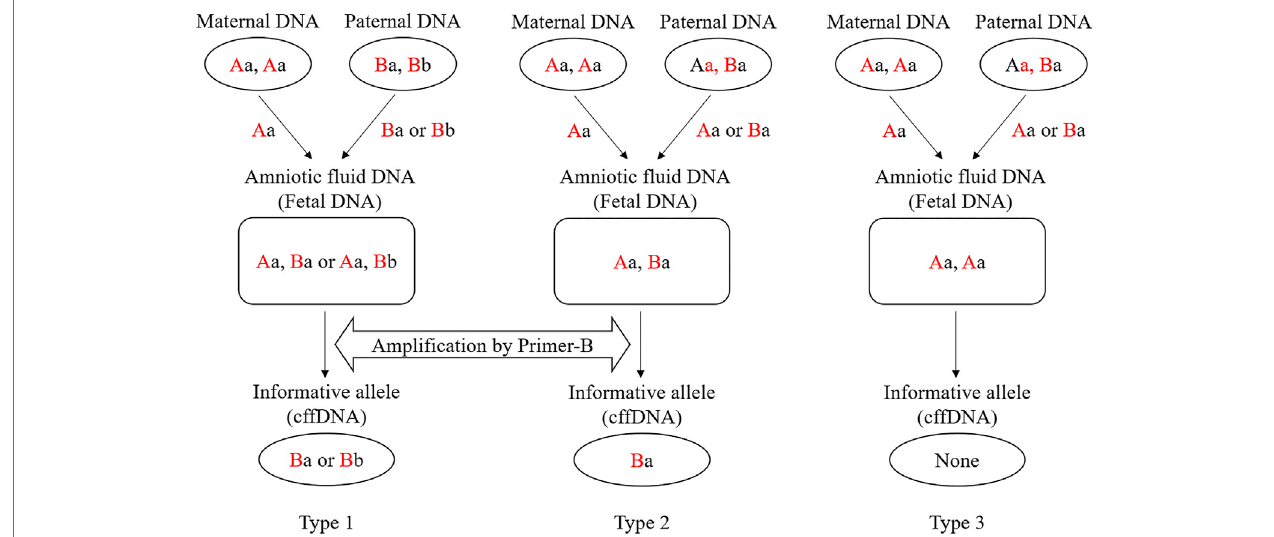
FIGURE1| Threemicrohaplotypepatterns(Types1,2,and3)inacfDNAmixtureandexamplesofgenotypecombinationsofparentsandfetus.Redcapitalletters indicatetheSNP1genotypes( “ A ” canbeanyofA/G/C/T),andblacklowercaselettersindicatetheSNP2genotypes( “ a ” canbeanyofA/G/C/T).FortheSNP1inType1, the mother and father carry different SNP alleles. Therefore, no matter which allele(Ba or Bb) ofthe father is passed to the fetus, the corresponding allele-speci fi c primer can be used for targeting (Primer-B). For the SNP1 in Type 2, the father is heterozygous. Then the fetal DNA can only be recognized when the allele (Ba) inherited from the father isnot shared with the mother. For the SNP1 inType3, the father is heterozygous. When the allele (Aa) inherited from the father is shared with the mother, the fetal DNA cannot be